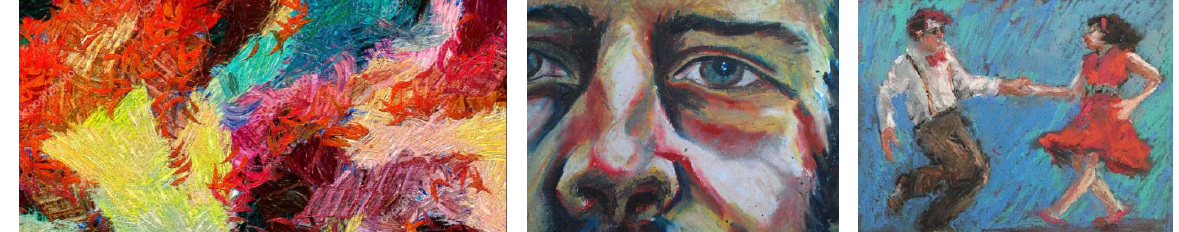
Figure 20. Oilpastel artworks similar to oilpainting